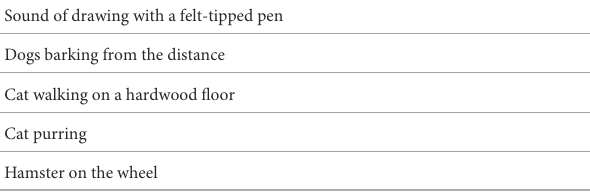
TABLE 2 Negative reactions frequently reported by patients with misophonia or